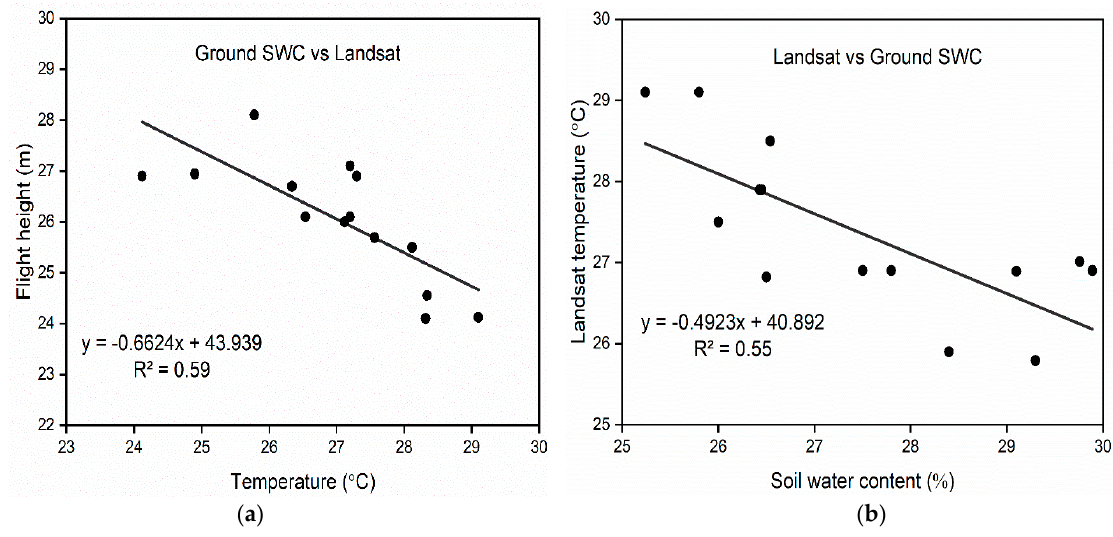
Figure 11. Relationship between the Landsat 8 LST and SWC, ( a ) DOY 230, ( b ) DOY 245.